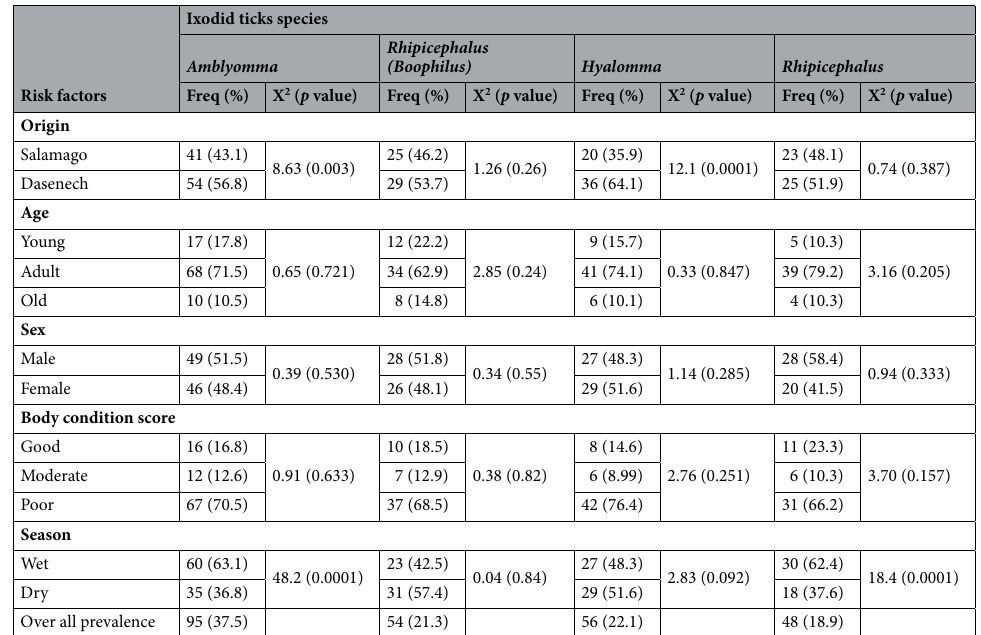
Table 4. The ixodid tick genera identified in the study district.